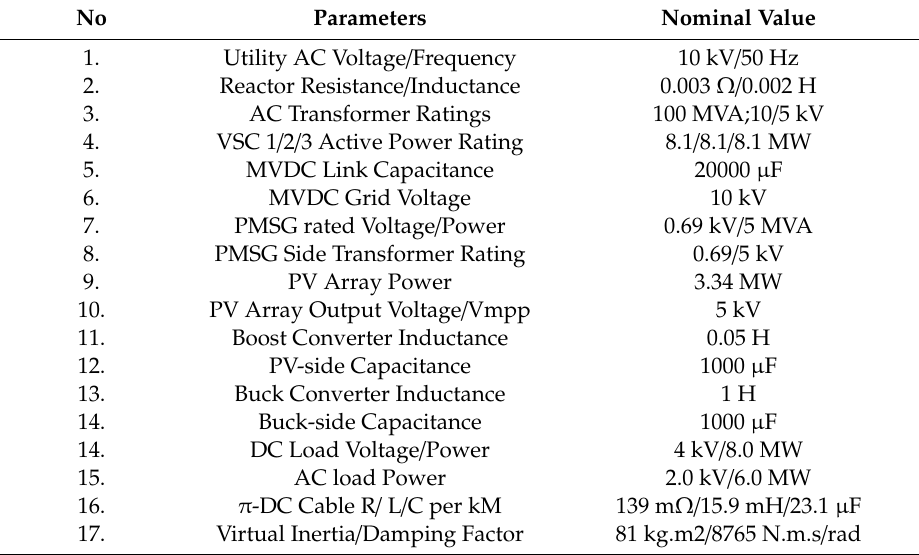
Table 1. Key parameters of the MVDC network.